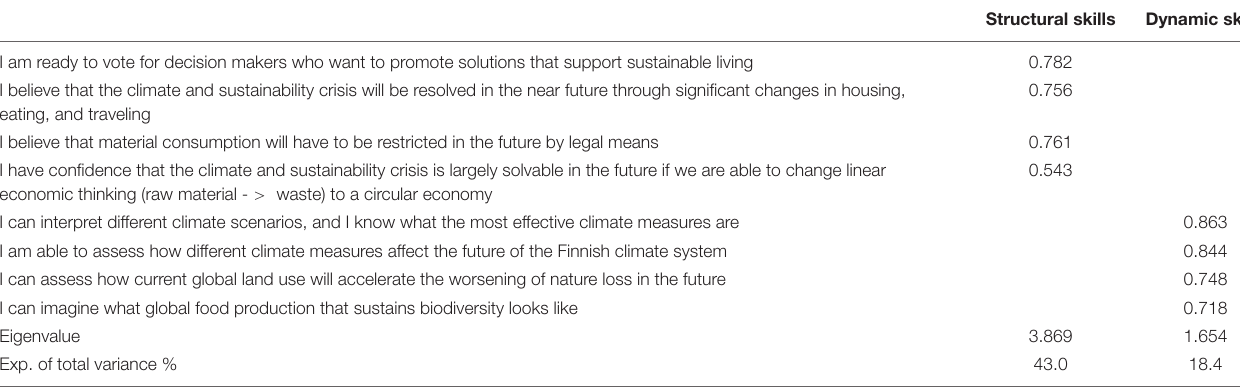
TABLE 4 | Finnish people’s anticipatory competence ( n =